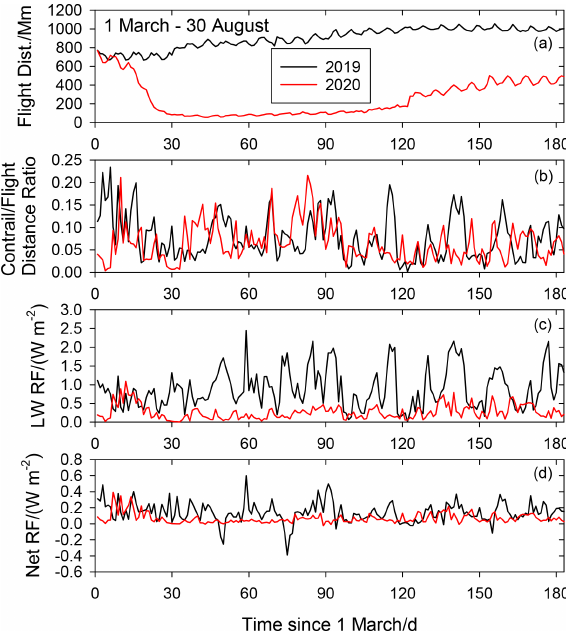
Figure 2. Mean values of (a) flight distance in air, (b) ratio of mean flight distance with contrails to total flight distance, (c) longwave (LW) RF, and (d) net RF versus time from 1 March to 30 August in 2019 (black curves) and 2020 (red). The data represent averages over the European domain and over a 24h